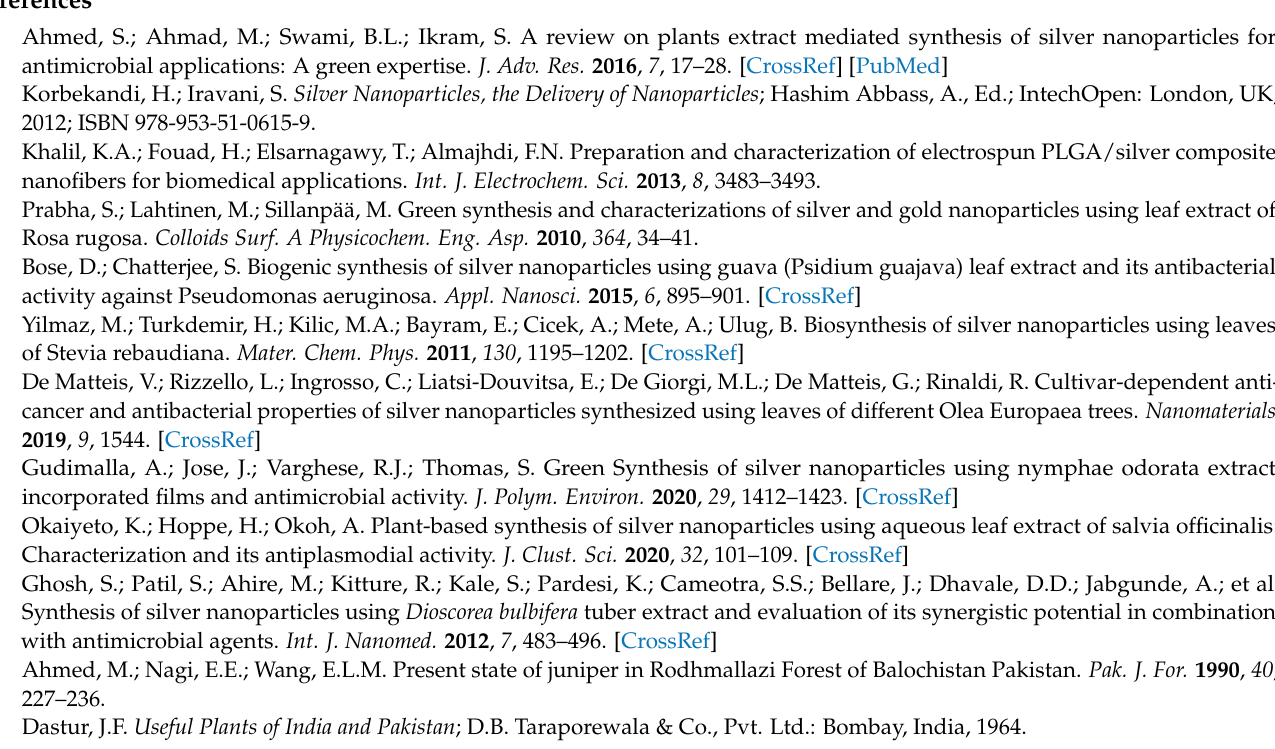
sample, Figure S2: NPs distribution, volume and size for three reading of A-AgNPs sample, Figure S3: TEM image presenting shape and size for the distributed O-AgNPs, Figure S4: TEM image presenting shape and size for the distributed